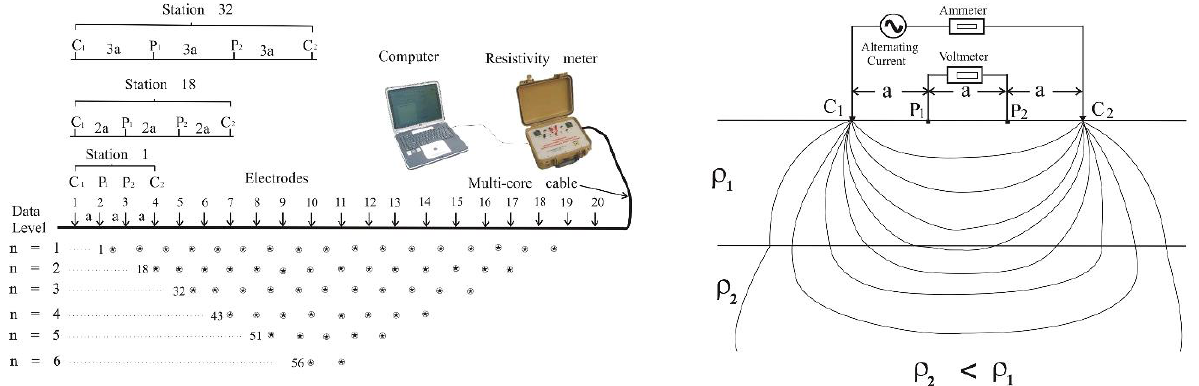
Figure 3. (Left panel) A representative sketch of resistivity measurement system with multiple electrodes, multicore cable and multichannel resistivity meter is shown (modified from Coşkun et al., 2016) [12]. (Right panel) The electrical current lines are illustrated (accepted from Coşkun, 2009)